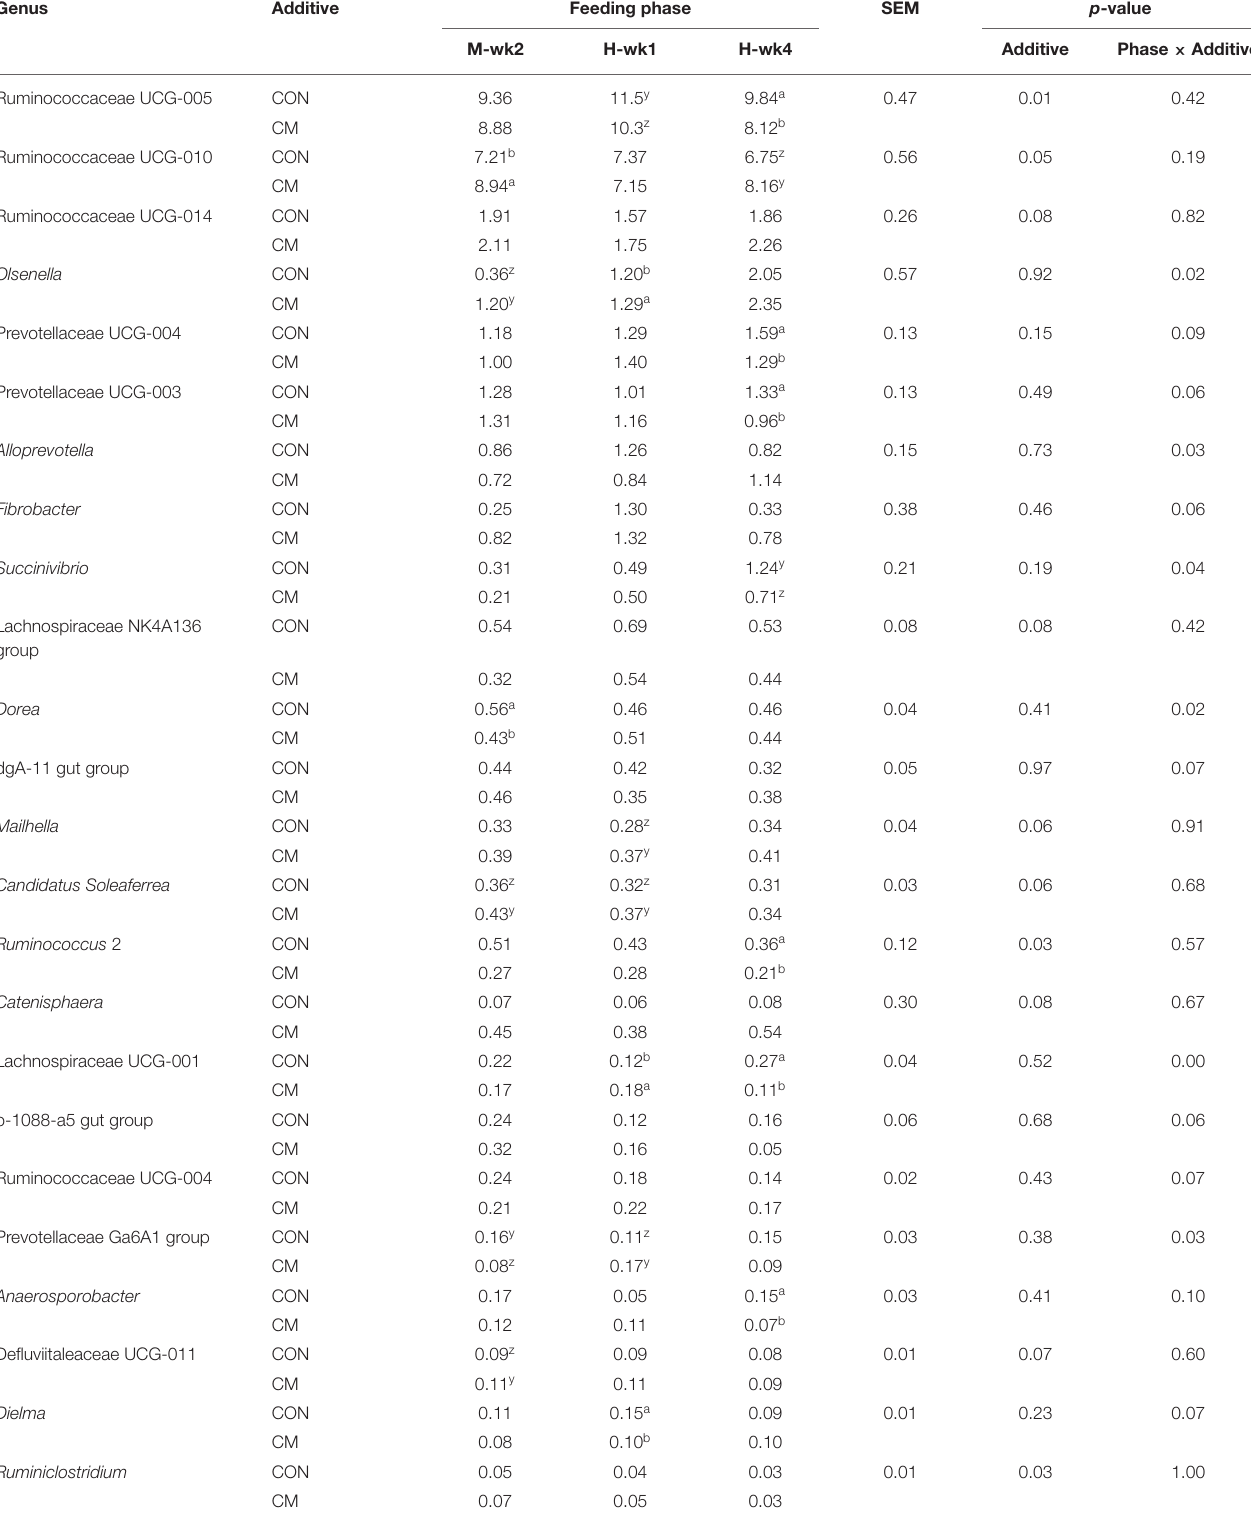
TABLE 2 | Relative abundance of bacterial genera significantly ( p ≤ 0.05) or tendentially (0.05 < p ≤ 0.10) affected by feed additive (CM) or an interaction of feed additive with feeding phase. Genus Additive Feeding phase SEM